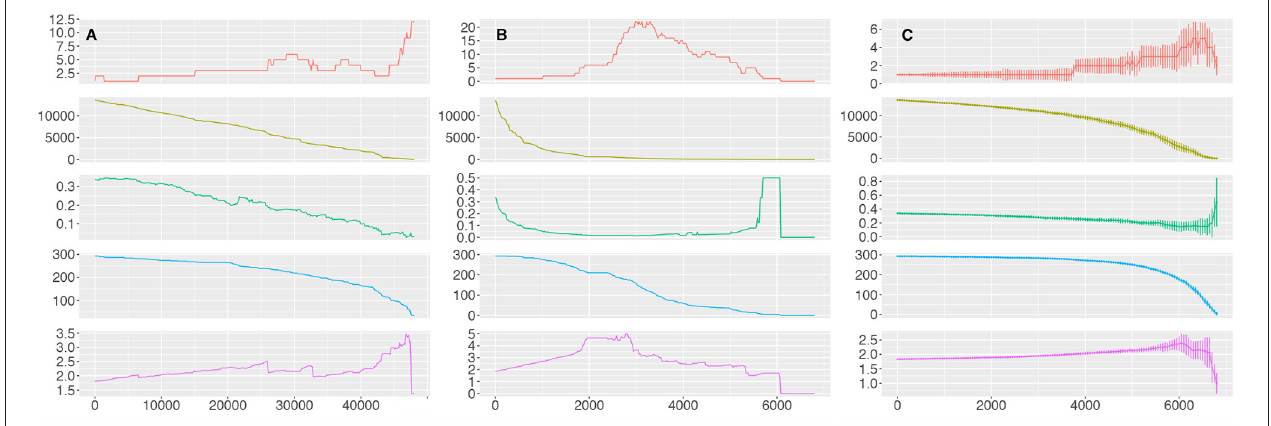
FIGURE 8 | Percolation of the GCC. The results for the percolation analysis removing edges ordered by descending values of edge betweenness (A) , nodes ordered by descending values of node degree (B) and nodes chosen at random (C) . Each plot shows either the number of edges removed (A) or nodes removed (B,C) from the molecular interaction network in the X axis and the number of components, the number of edges, the mean degree, the number of nodes (pathways) and the average shortest path length of the pathway network in the Y axis for each iteration (top to